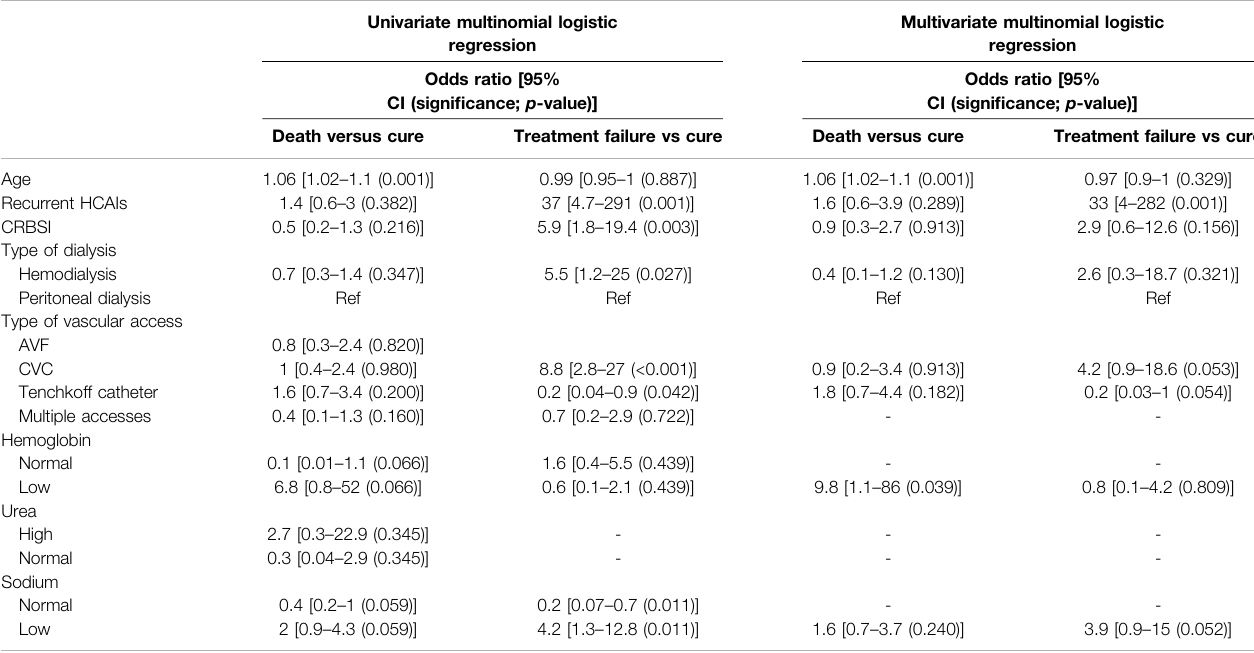
TABLE 5 | Multinomial logistic regression for risk factors associated with unsuccessful treatment outcomes.